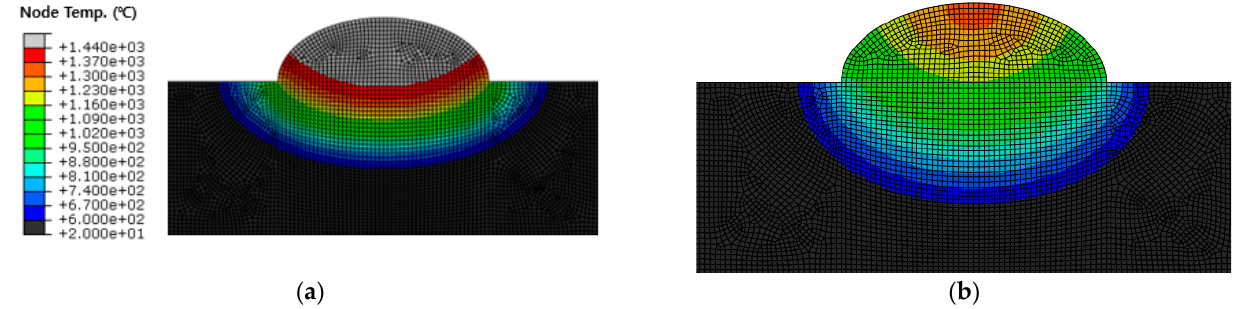
Figure 11. Heat transfer analysis results. Times were ( a ) 0 s after the welding heat source has passed (Max HAZ width); ( b ) 1.6 s after the welding heat source has passed (Max HAZ Depth). Table 8 . HAZ dimension and comparison .